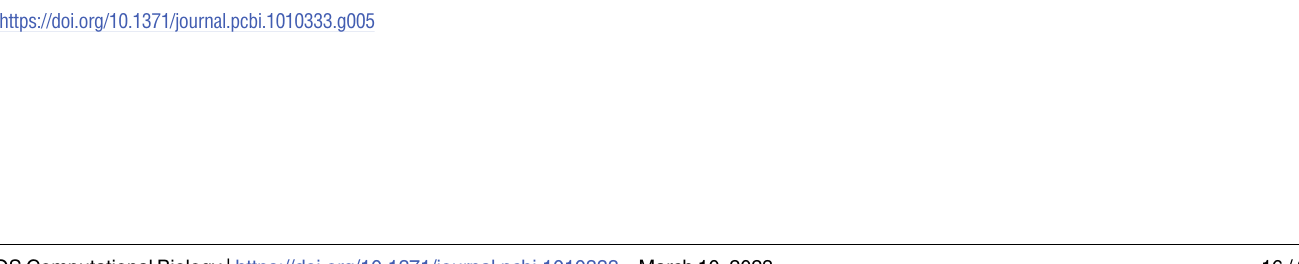
PLOS Computational Biology | https://doi.org/10.1371/journal.pcbi.1010333 March 10,